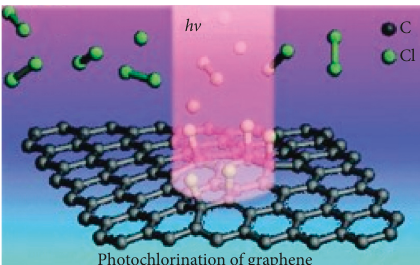
Figure 13: Chemical structure of graphene.